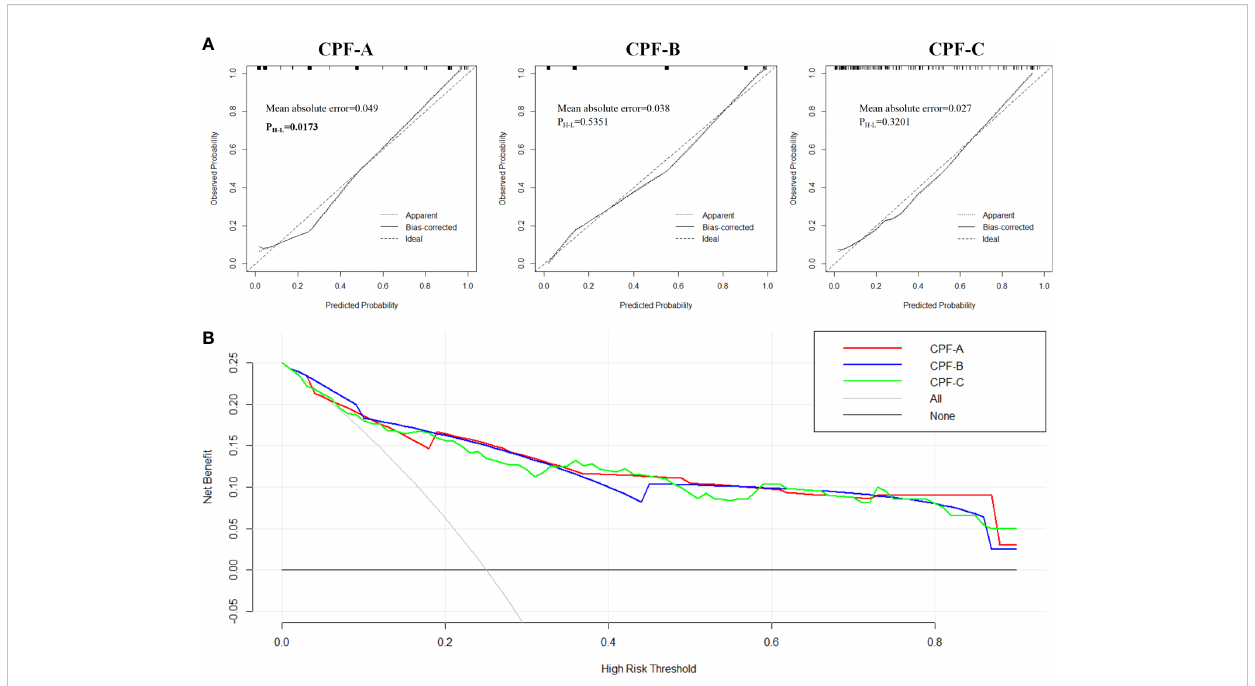
FIGURE 7 The evaluation of CPF-A, CPF-B, and CPF-C in the external validation samples. (A) Calibration curves of high-risk patients for GBC predicted by CPF- A, CPF-B, and CPF-C. (B) Decision curves of CPF-A, CPF-B, and CPF-C.